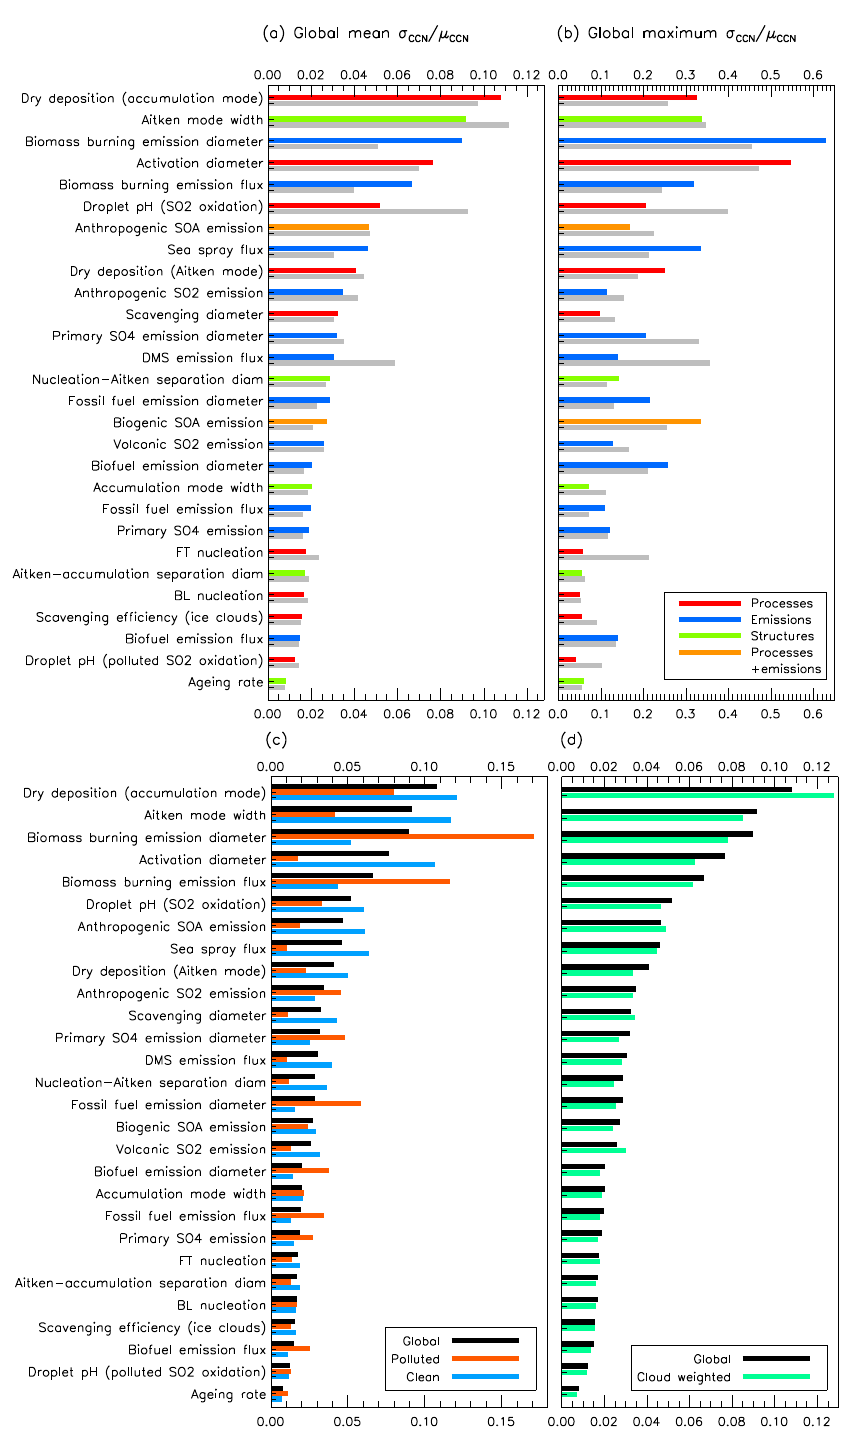
Fig. 8. Global summary of the ranked parameter uncertainties for CCN. (a) Global mean σ CCN ,i /µ CCN where i is the parameter, calculated by globally averaging σ CCN ,i /µ CCN over all grid boxes, weighting by grid-box area. The ranked uncertainties are shown in colour for July and in grey for January. The colours show the classification of the parameters according to model processes (red), emissions (blue), processes and emissions (orange) and the model structure (green). (b) Global maximum σ CCN ,i /µ CCN calculated over a coarser grid (32 × 16 grid boxes) than the GLOMAP grid (128 × 64 grid boxes) in order to suppress noise in the data. (c) Stratified into polluted and clean mean σ CCN ,i /µ CCN for July. Polluted is defined as BC > 100ngm − 3 and clean as BC < 50ngm − 3 . The black bars are July global means from (a) . (d) Global rankings in July weighted by ISCCP global low level cloud volume fraction.